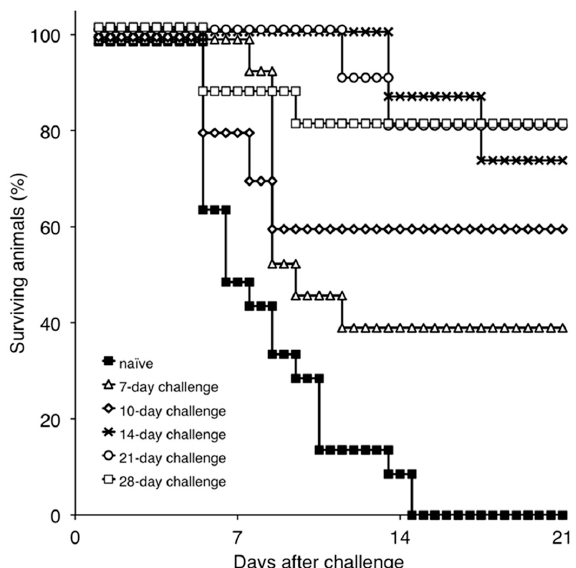
Figure 3. Percentage of surviving animals challenged with Pret4 virus at different times post intramuscular (IM) inoculation with Pret4 Δ 9GL. Swine were infected with 10 4 HAD 50 /mL Pret4 Δ 9GL virus and challenged with virulent Pret4 (same dose and route) at either 7 ( n = 15), 10 ( n = 10), 14 ( n = 15), 21 ( n = 10), or 28 ( n = 15) days later.